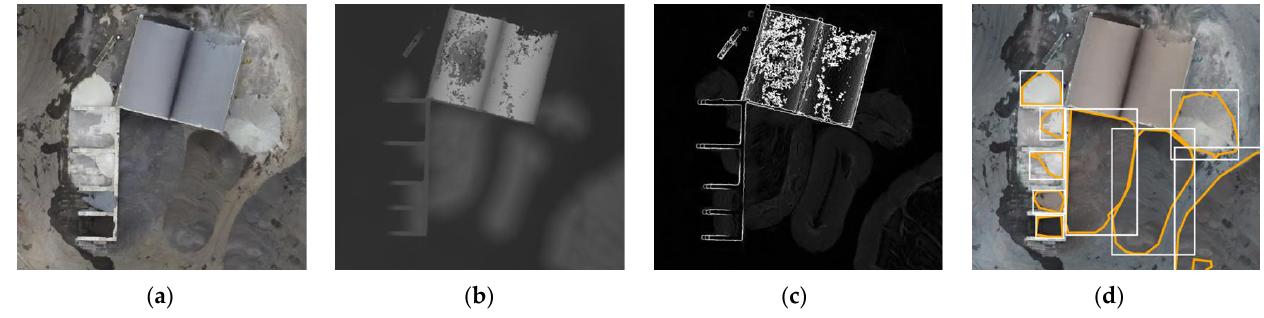
Figure 20 . Selected area from test site B as an example for the accurate detection and segmentation of different types of piles. Displayed ( a ) as RGB orthomosaic, ( b ) as relative heights, ( c ) as local slope, and ( d ) as RGB orthomosaic, together with the predictions as polygon-boundaries and bounding boxes.